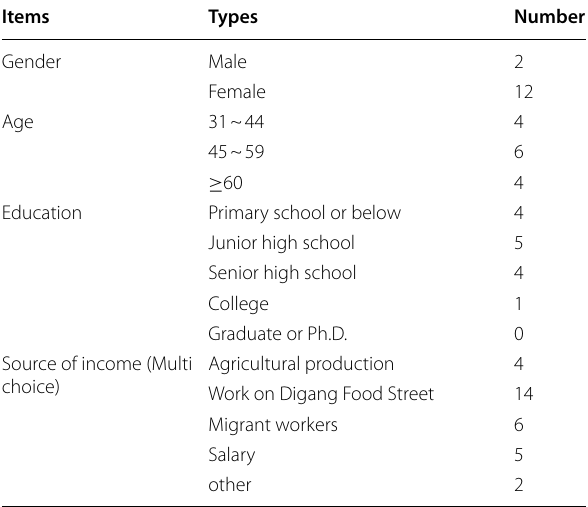
Table 1 The demographic characteristics of the interviewees in Digang Food